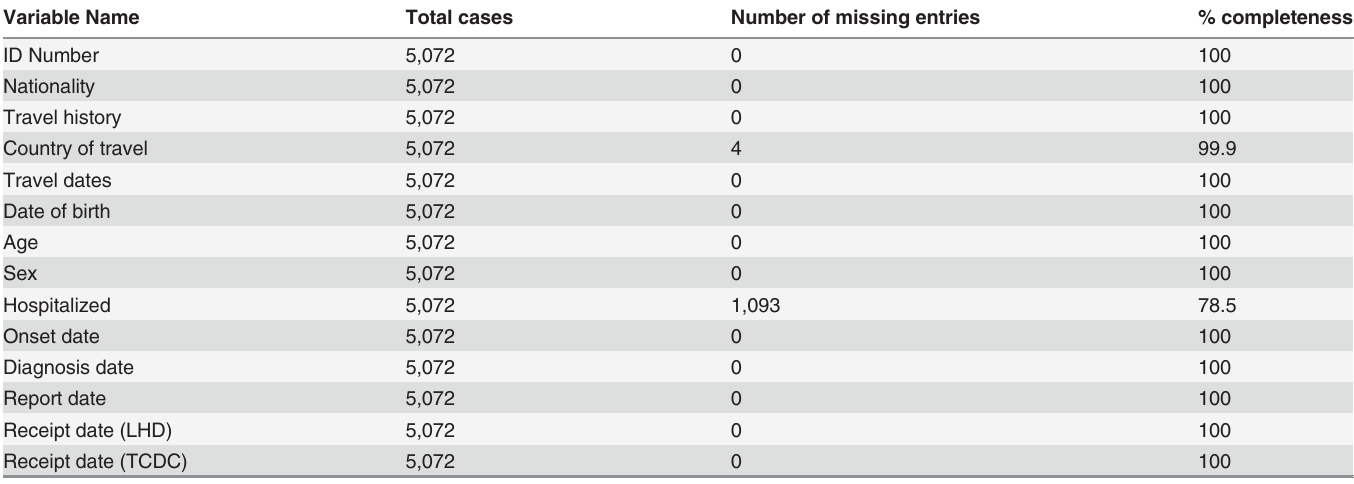
Table 1. Percentage completeness of variables in dataset of confirmed dengue fever cases reported to the National Disease Surveillance System, Taiwan, 2010 –